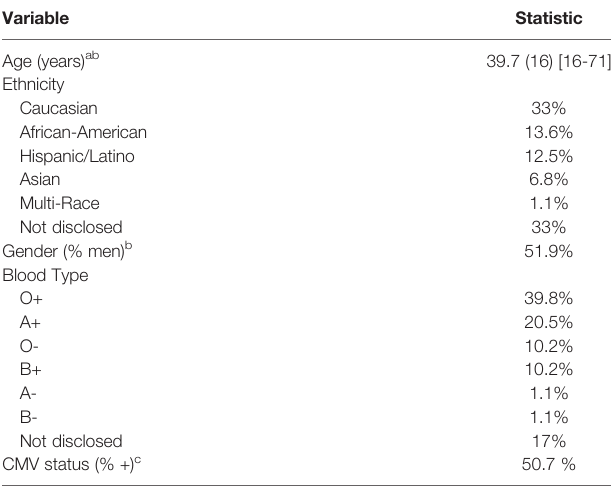
TABLE 1 | Demographic characteristics of donors